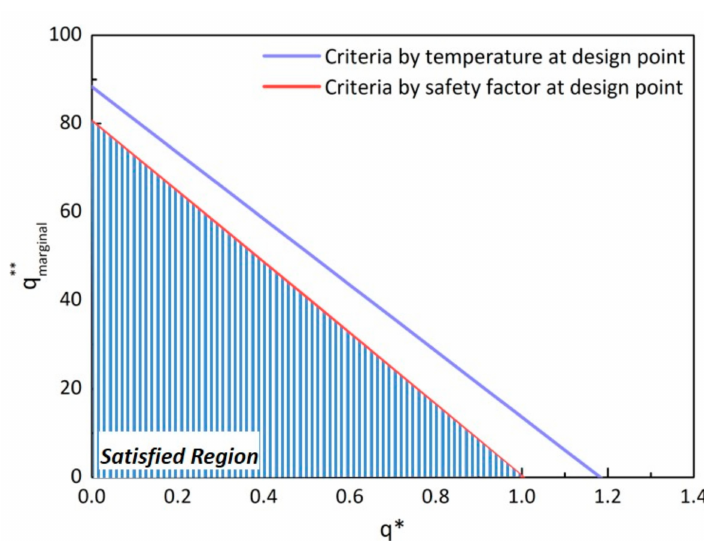
Figure 8. Heat-absorbing capacity of the divertor module considering the design criteria of temperature and safety factor with changes in normalized heat flux ( q *) and heat generation ( q